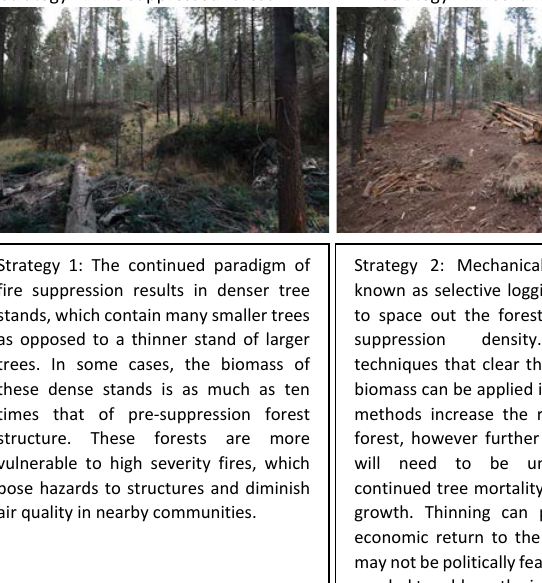
Strategy 1: Fire suppressed forest Strategy 2: Mechanically